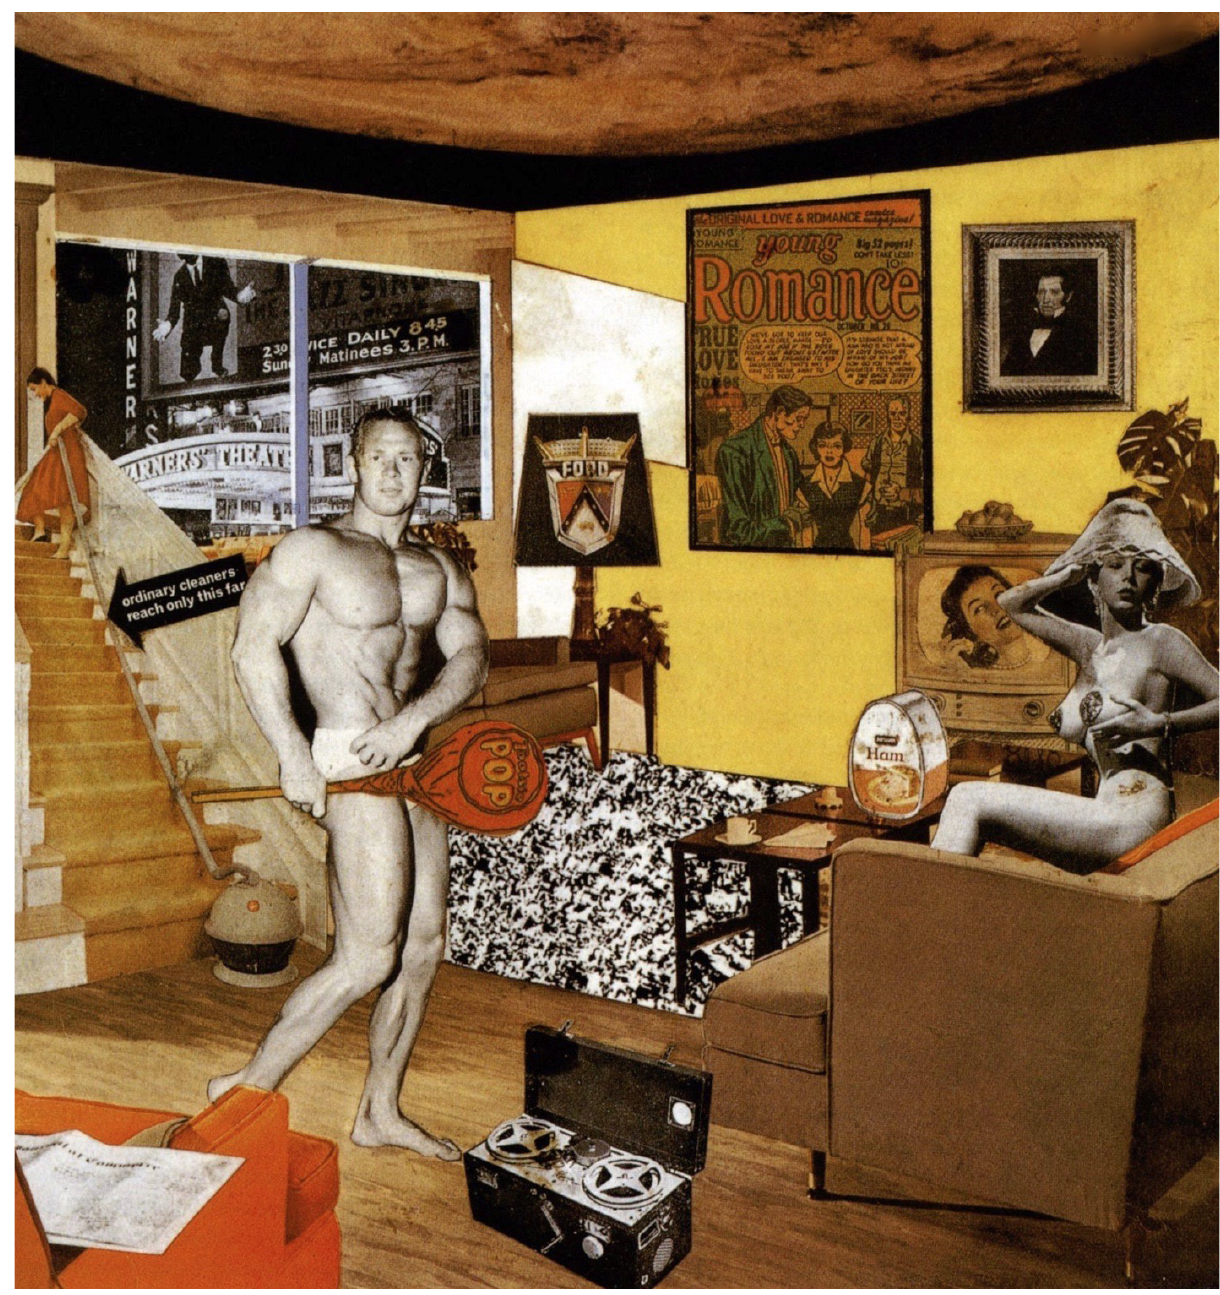
Richard Hamilton ‘Just what is it that makes today’s homes so different, so appealing?’ (1956) The white message on the black arrow in the stair reads: ‘Other cleaners only reach this